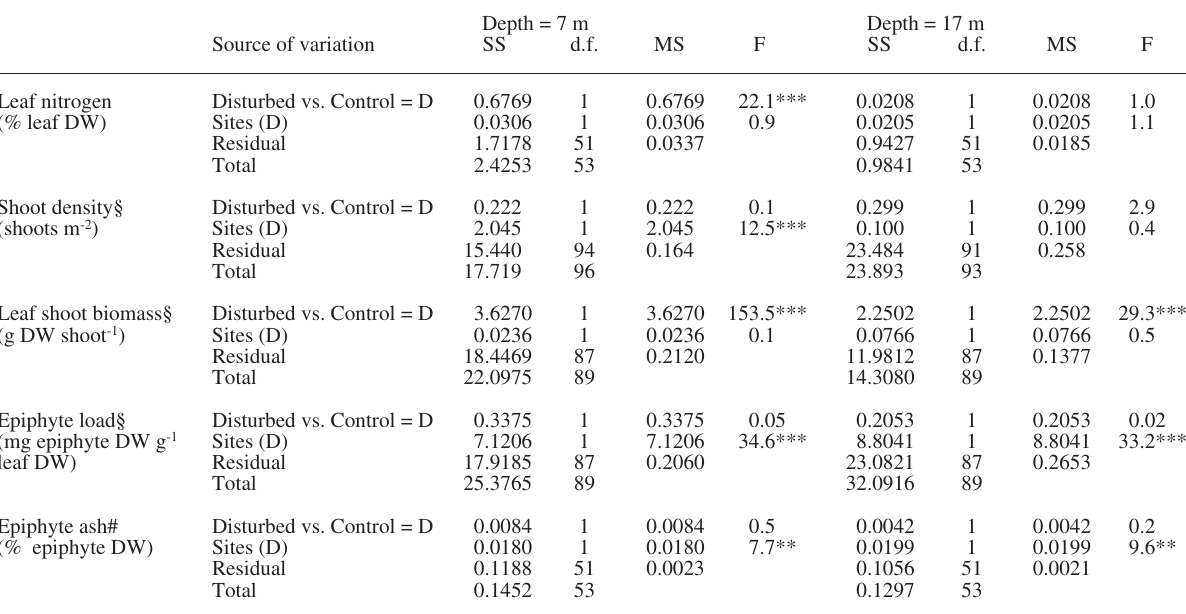
Table 1. – results of an asymmetrical analysis of variance to evaluate if leaf nitrogen, shoot density, leaf shoot biomass, epiphyte load, and the ash content of the epiphytes were different in a disturbed site (es Port) and two control sites (cala santa María, es Burri) at two depths (7 m, 17 m) in cabrera archipelago national Park (spain) from 2004 to 2006. dW: dry weight. significant sources of variation are indicated by asterisks: ** , P <0.05; *** , P <0.005. § data were log -transformed. # data were arcsin-transformed. e